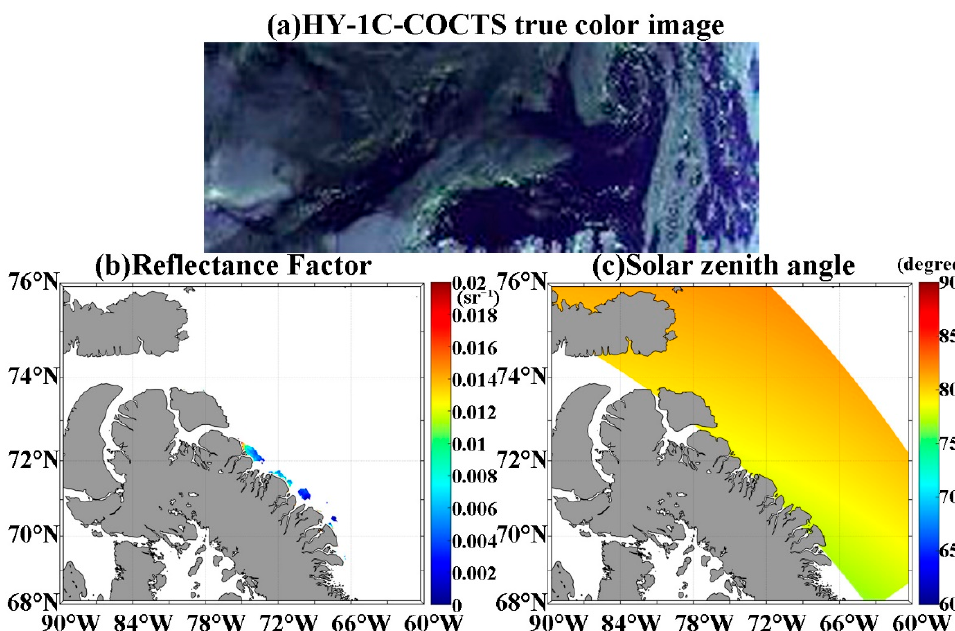
Figure 1. Observation data of HY-1C-COCTS in Baffin Bay on 5 October 2020: ( a ) true color image; ( b ) Rrs in the 443 nm band; ( c ) SZA.